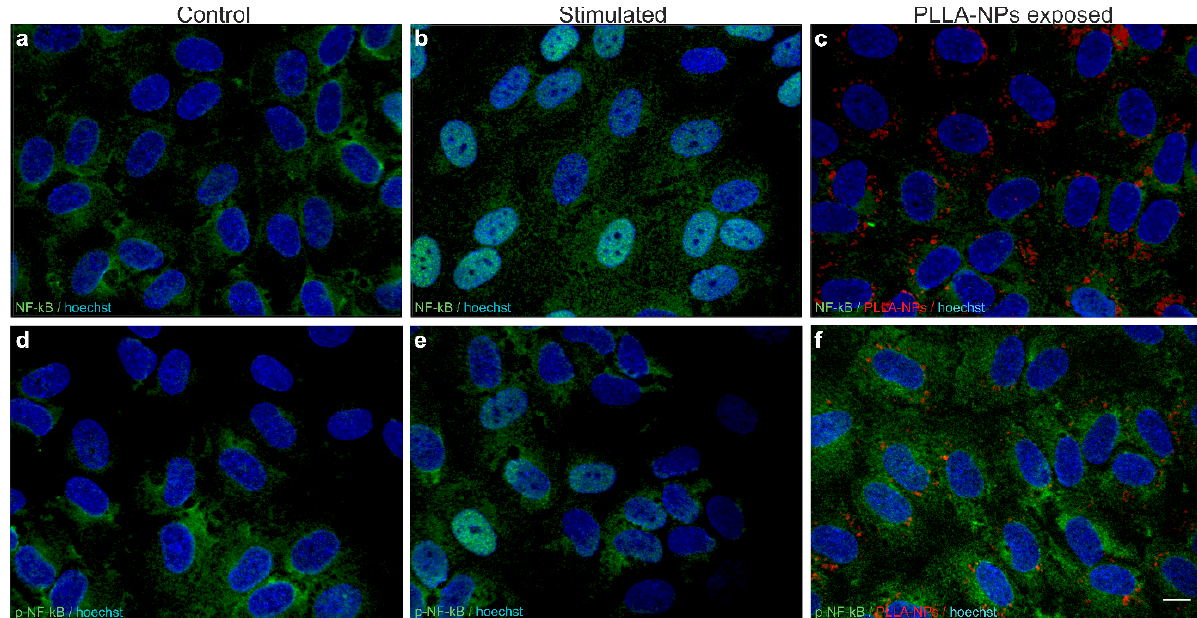
Figure 4. Representative microscopic images of effects of polymer ‐ coated NPs on the expression of NF ‐κ B ( a – c ) and p ‐ NF ‐ κ B ( d – f ) (green). Non ‐ exposed cells were used as control ( a , d ). Stimulation with lipopolysaccharide (LPS) (1 μ g/mL) for 2 h on DIV7 ( b ) or a combination of tumor necrosis factor (TNF) ‐α (1 ng/mL) and IFN ‐γ (1 ng/mL) for 16 h, starting on DIV6 ( e ) was carried out as positive controls. hBLECs were exposed to PLLA ‐ NPs for 2 h on DIV7 at a concentration of (24.9 μ g/mL) ( c , f ). Cell nuclei were counterstained with Hoechst (blue). Scale bars: 10 μ m in each plane.